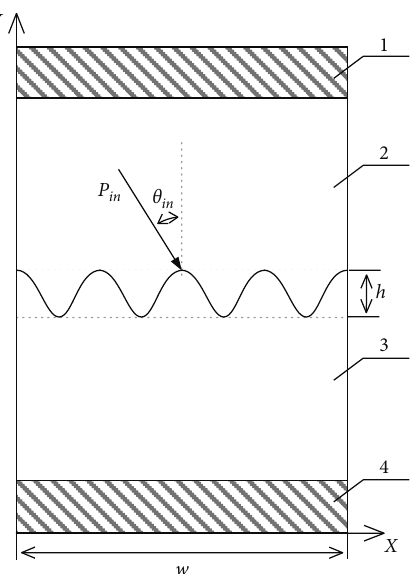
Figure 1: The 2D cell used to calculate evanescent field parameters in the near-field region of the nanoirregularities of the quartz surface. Regions 1, 2, 3, and 4 are, respectively, the regions of the upper absorbing layer, the quartz layer, the chlorine gas layer, and the lower absorbing